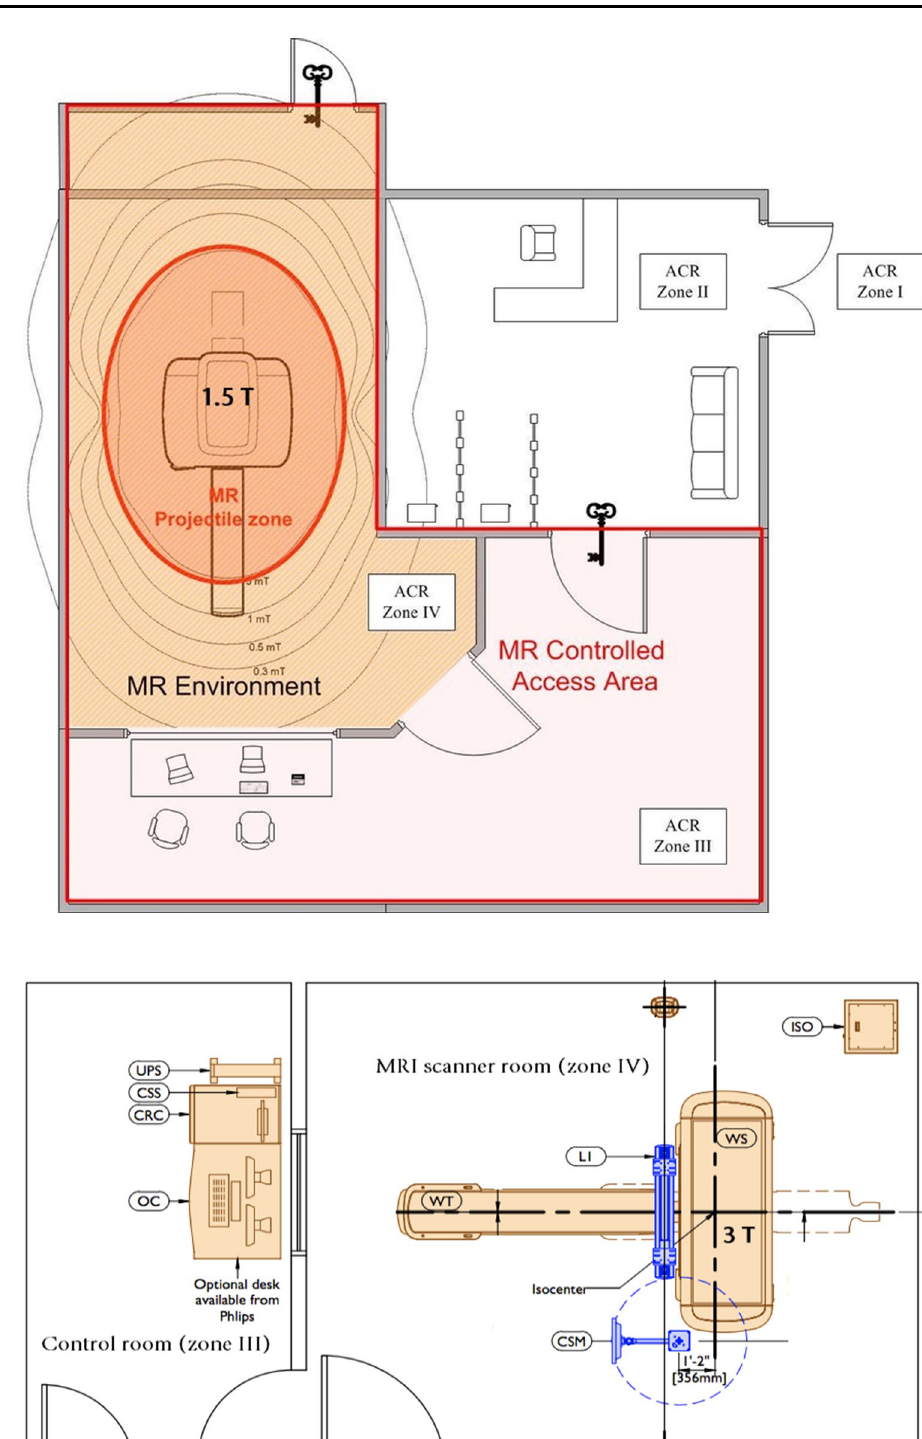
Fig. 1 1.5 T MRI unit layout